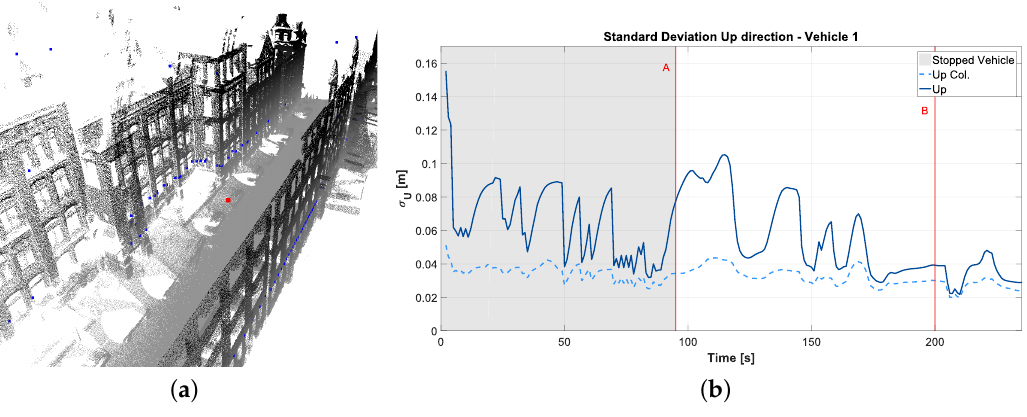
Figure 17. ( a ) Environmental model obtained from preprocessed point cloud. ( b ) Standard deviation results from the LKF estimation in the up direction (collaborative approach versus single